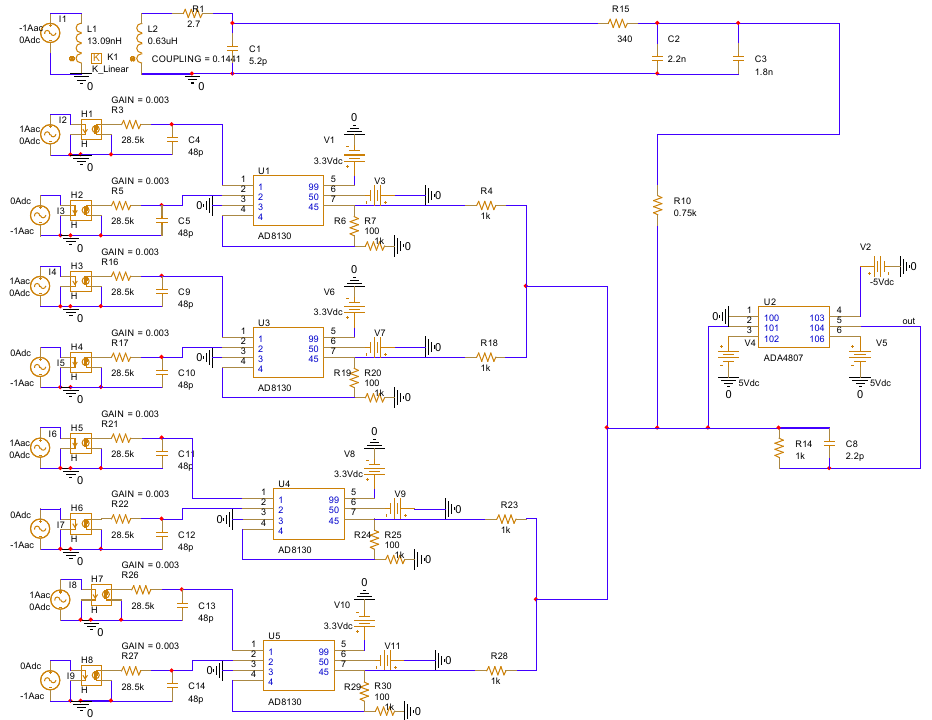
Table 3. Electrical parameters of composite current sensor coupling circuit.